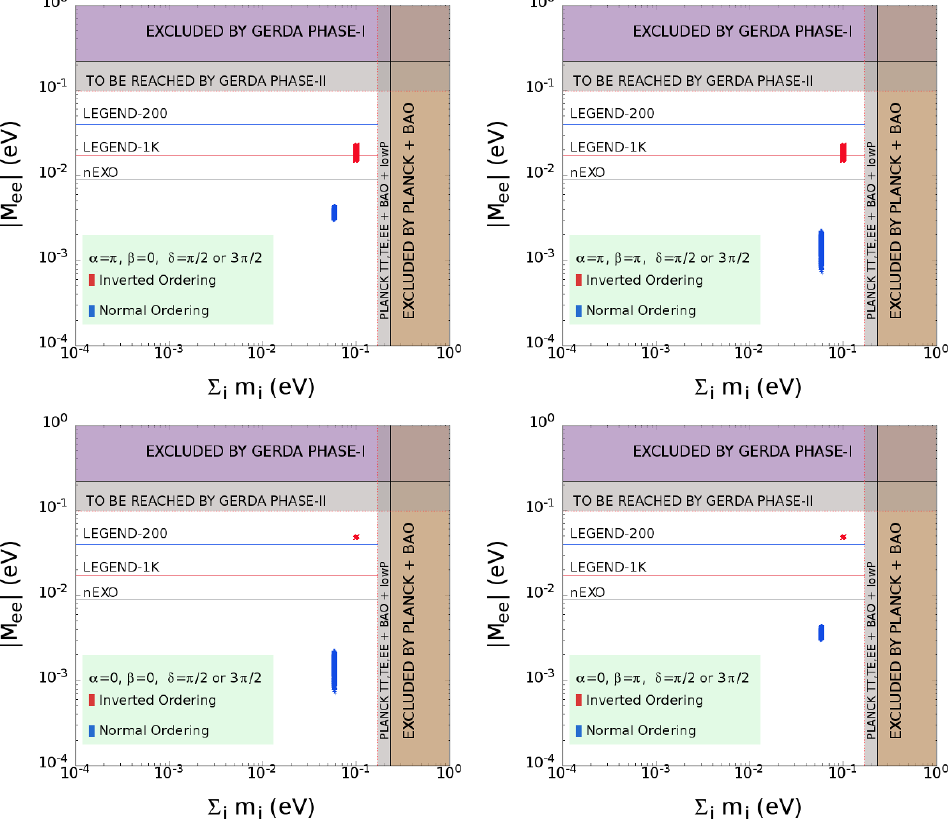
Figure 2 . Plots: j M ee j vs. (cid:6) i m i for both the mass